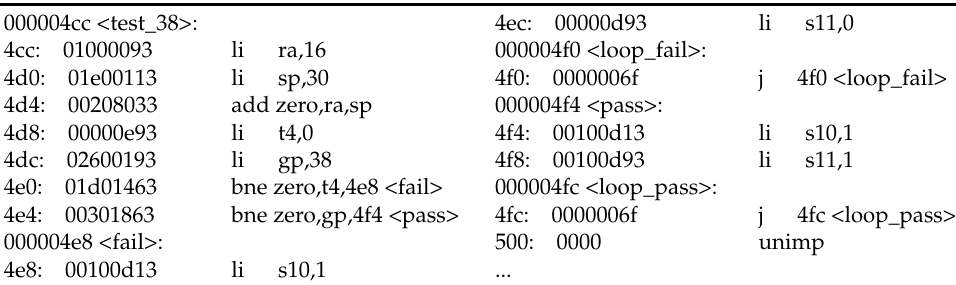
Figure 26. Decoding-stage error is flushed by jump instruction. Code 2. rv32ui-p-add partial assembly code example-2.